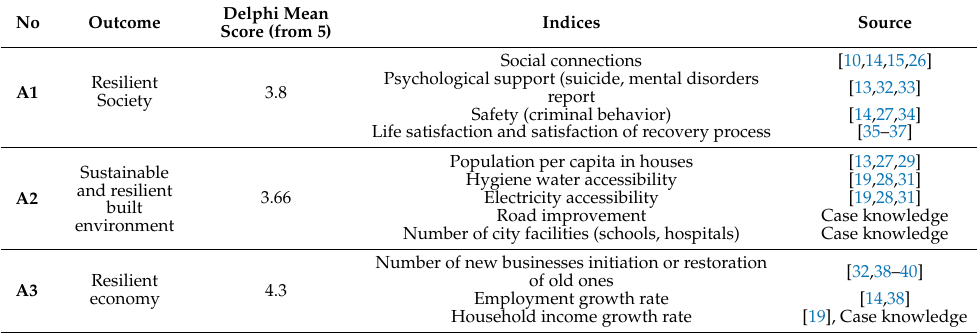
Table 1. Comprehensive and long-lasting success dimension of SNDR projects based on the com- munity perspective.